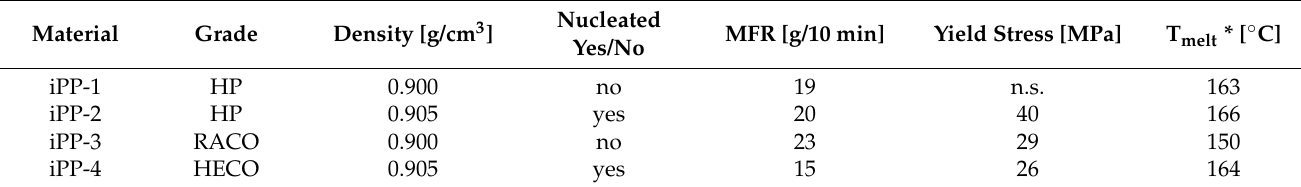
Table 1. Material properties. MFR (melt flow rate)—230 ◦ C/2.16 kg, T melt —DSC (differential scanning